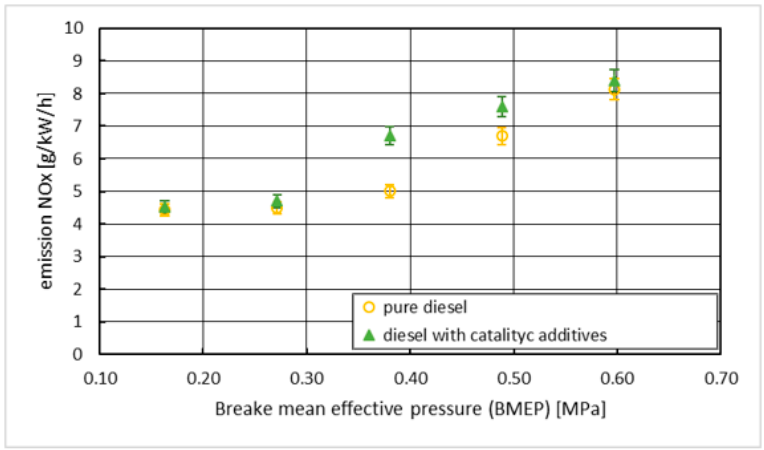
Figure 4. NOx emission vs. brake mean effective pressure at an engine speed of 2000 rpm.